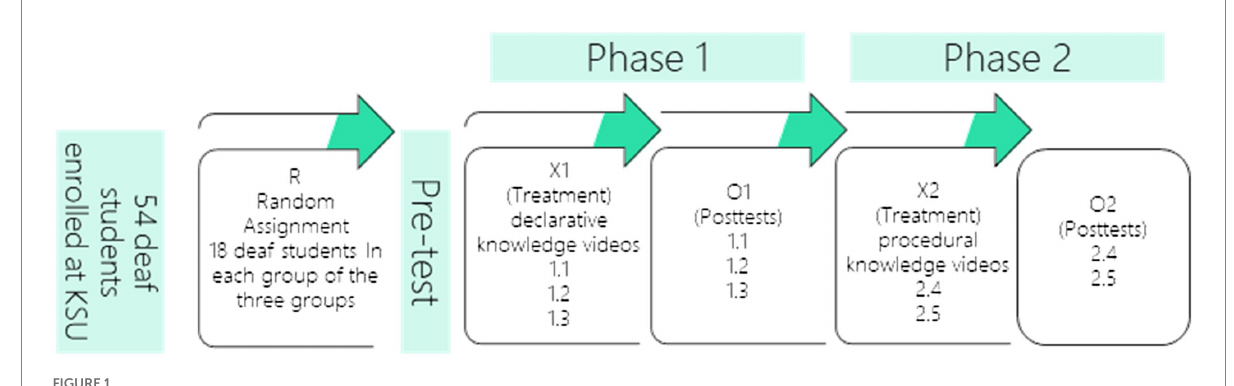
FIGURE 1 Research design: pre- posttest